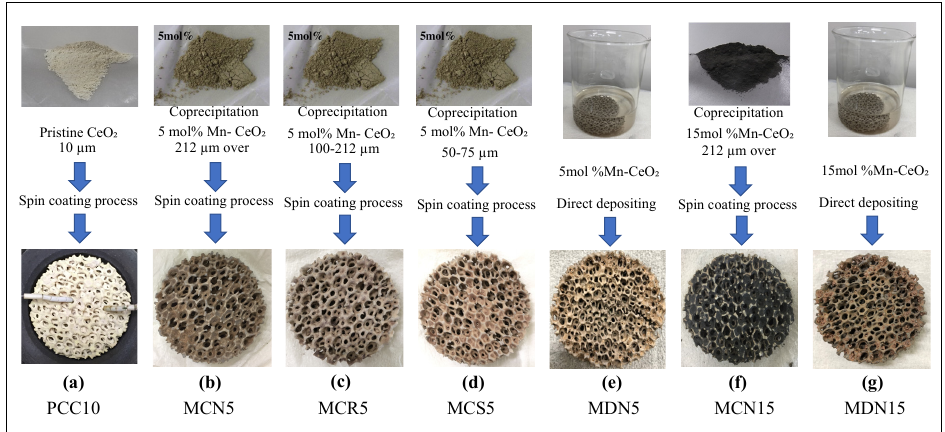
Figure 3. Photograph of CeO 2 /Mn-CeO 2 powder samples and reactive CeO 2 /Mn-CeO 2 coated foam devices. ( a ) Pristine CeO 2 spin-coated foam device (PCC10); ( b ) co-precipitation with 5 mol% Mn-CeO 2 spin-coated foam device with over 212- µ m powder size (MCN5); ( c ) co-precipitation with 5 mol% Mn-CeO 2 spin-coated foam device with powder size of 100–212 µ m (MCR5); ( d ) co- precipitation with 5 mol% Mn-CeO 2 spin-coated foam device with powder size of 50–75 µ m (MCS5); ( e ) direct deposition of 5 mol% Mn-CeO 2 foam device (MDN5); ( f ) co-precipitation with 55 mol% Mn-CeO 2 spin-coated foam device with over 212- µ m powder size (MCN15); and ( g ) direct deposition of 15 mol% Mn-CeO 2 foam device